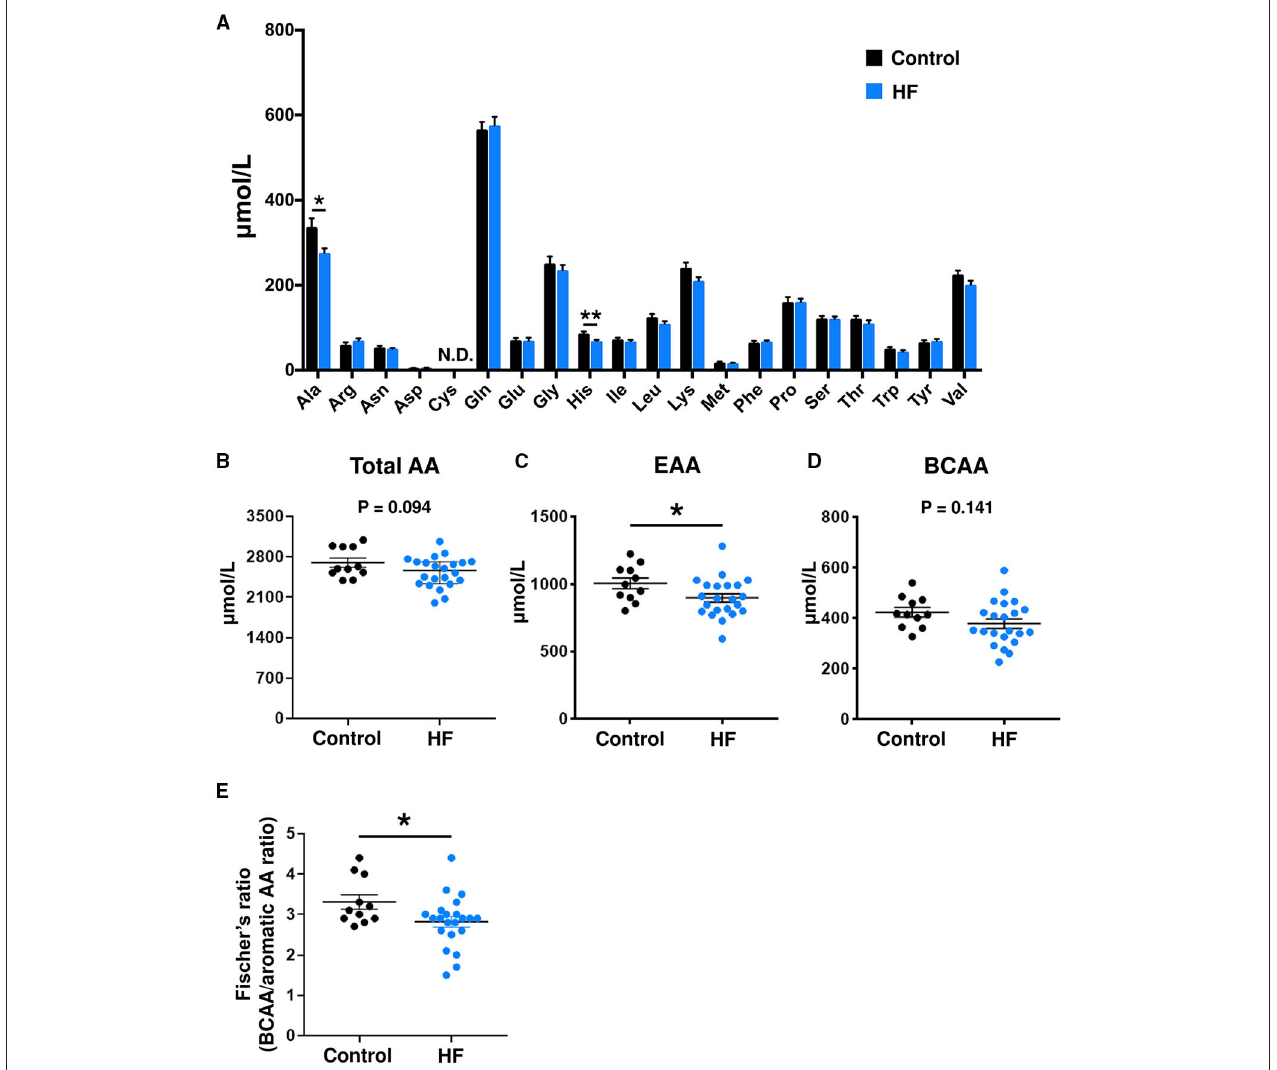
FIGURE 2 | Comparison of plasma amino acid (AA) concentrations between heart failure (HF) patients (n 22) and control subjects ( n 11). (A) Plasma = = concentrations of each AA. (B) Plasma concentrations of total AAs. (C) Plasma concentrations of total essential AAs (EAAs), including His, Ile, Leu, Lys, Met, Phe, Thr, Trp, and Val. (D) Plasma concentrations of branched chain AAs (BCAAs), including Leu, Ile, and Val. (E) Fischer’s ratio, which is the ratio of BCAAs to aromatic AAs (Phe and Tyr). The data are presented as mean SEM. * P < 0.05, ** P < 0.01. Ala, alanine; Arg, arginine; Asn, asparagine; Asp, aspartic acid; Cys, cysteine; Gln, ± glutamine; Glu, glutamic acid; Gly, glycine; His, histidine; Ile, isoleucine; Leu, leucine; Lys, lysine; Met, methionine; Phe, phenylalanine; Pro, proline; Ser, serine;